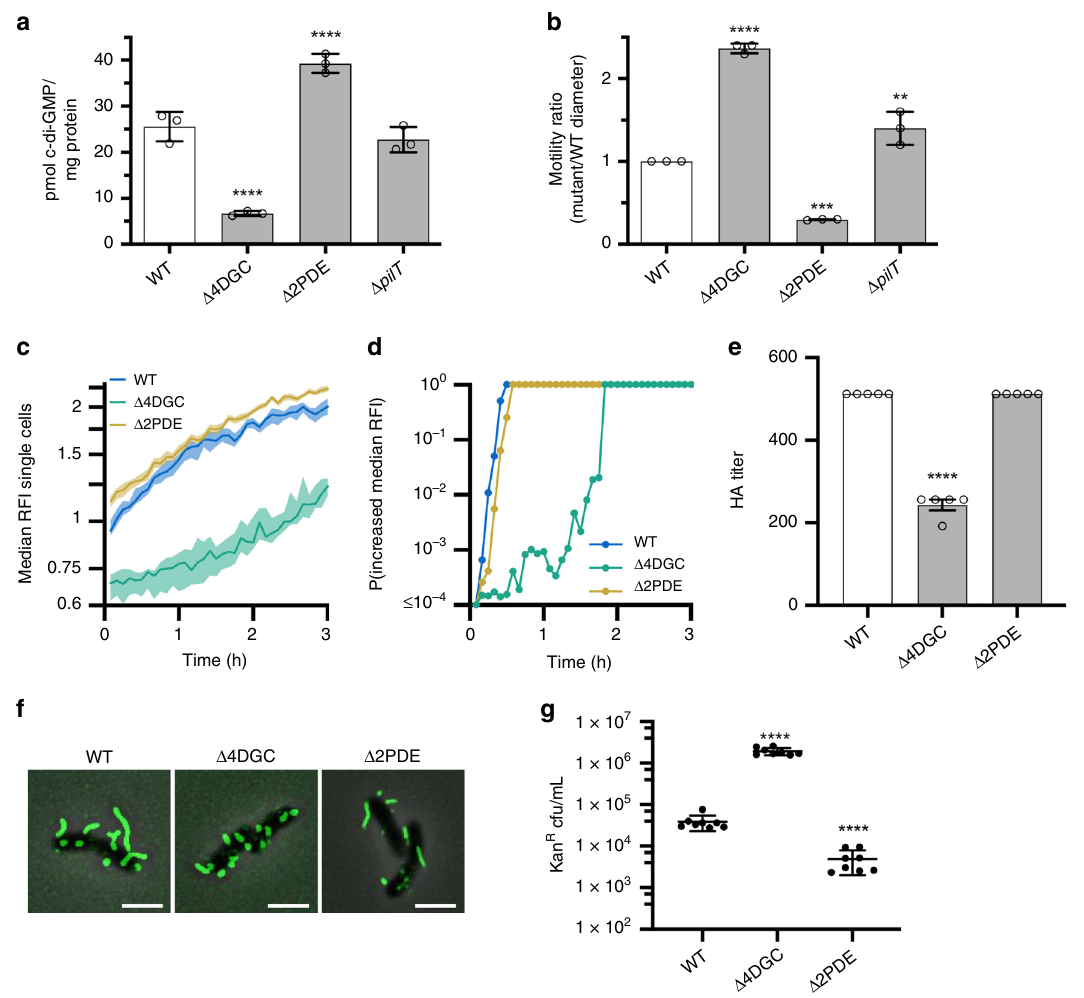
Fig. 3 Reduced intracellular c-di-GMP levels increase fl agellar motility, decrease MSHA surface piliation, and increase frequency of MSHA retraction. a c-di-GMP levels as quanti fi ed by LC-MS/MS. Graphs depict data as the mean, with error bars representing the standard deviation. Statistical analysis, n = 3 biological replicates per strain, one-way ANOVA compared to WT with Dunnett correction for multiple comparisons, **** p ≤ 0.0001. Source data provided as a Source Data fi le. b Flagellar motility in soft agar. Data presented as the ratio of mutant motility to WT motility. Graphs depict data as the mean, with error bars representing the standard deviation. n = 3 biological replicates per strain. Statistical analysis: one-way ANOVA compared to WT with Dunnett correction for multiple comparisons: Δ 4DGC **** p ≤ 0.0001, Δ 2PDE *** p = 0.0002, Δ pilT * p = 0.0141. Source data provided as a Source Data fi le. c Measurement of c-di-GMP levels in single cells inside a fl ow cell using the biosensor. Lines indicate the median RFI values per time point, and the shaded areas represent the 95% con fi dence intervals obtained from the bootstrap sampling distribution of the median RFI values. Time 0 H corresponds roughly to when cells initially encounter the surface of the fl ow cell. ( d ) Plot of the probability of c-di-GMP increase, calculated by comparing the bootstrap sampling distributions of the median RFI values between every time point ( I t ) and the fi rst ( I 1 ). C-di-GMP is determined to be increasing if I t / I 1 ≥ 1.05. e Analysis of surface MSHA production via hemagglutination (HA) assay. The reciprocal of the lowest fold dilution at which equivalent cell levels were able to agglutinate sheep erythrocytes (HA Titer) is plotted as the mean with error bars representing the SEM. For each strain n = 5 biological replicates were analyzed, with two technical replicates performed for each biological replicate. WT value is the same as shown in Fig. 2f. ND no observable hemagglutination at the highest cell concentration. Statistical analysis: each mutant HA titer was compared to WT via unpaired two-tailed Student ’ s t -Test, **** p ≤ 0.0001. Source data provided as a Source Data fi le. f Representative overlay images of fi ltered- fl uorescence and phase-contrast channels of mshA T70C strains within surface-associated cells stained with AlexaFluor 488 C 5 maleimide dye. Images representative of three independent analyses. Scale bars = 2 μ m. g VGJ Φ phage transduction levels. All in mshA T70C strain. Individual data points of kanamycin-resistant CFU/mL plotted with line at the mean and error bars representing the standard deviation. Biological replicates: n = 8 per strain. Statistical analysis: unpaired two-tailed Student ’ s t -Test, **** p ≤ 0.0001. Source data provided as a Source Data fi Δ 4DGC cells show a signi fi cant lag in c-di-GMP production/ protein. 41,42 Analysis of c-di-GMP levels among WT surface- attached single cells in a fl ow cell model of surface accumulation (Fig. 3c), as well as signi fi cant lag in the attachment 26,42 , showed that intracellular c-di-GMP levels (as probability of the median RFI increasing reaching 1 (Fig. 3d). median reporter relative fl uorescence intensity, or RFI) begin Individual deletions of each DGC demonstrate similar rates of to increase immediately upon attachment to the surface RFI increase and probabilities compared to WT (Supplemen- (Fig. 3c), reaching a probability of the median RFI increasing tary Fig. 7a, b). This fi nding suggests that the lag in of 1 within 30 min after attachment (Fig. 3d). Comparably, production/accumulation of c-di-GMP are cumulative effects